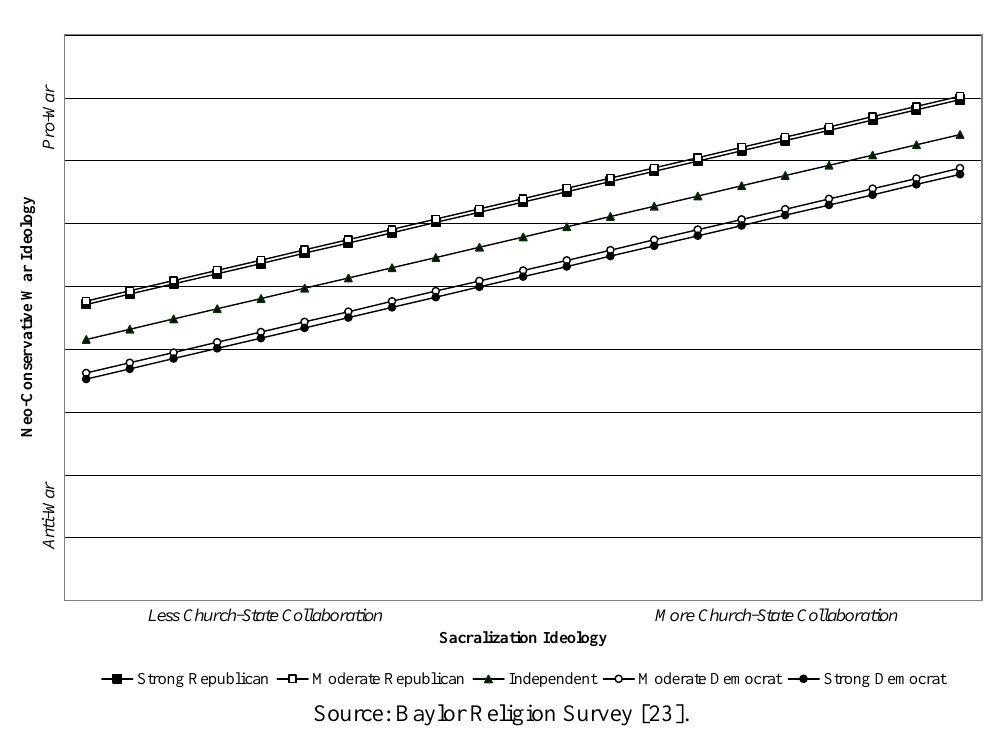
Figure 1. Predicted probabilities of pro-war attitudes (by sacralization ideology and political